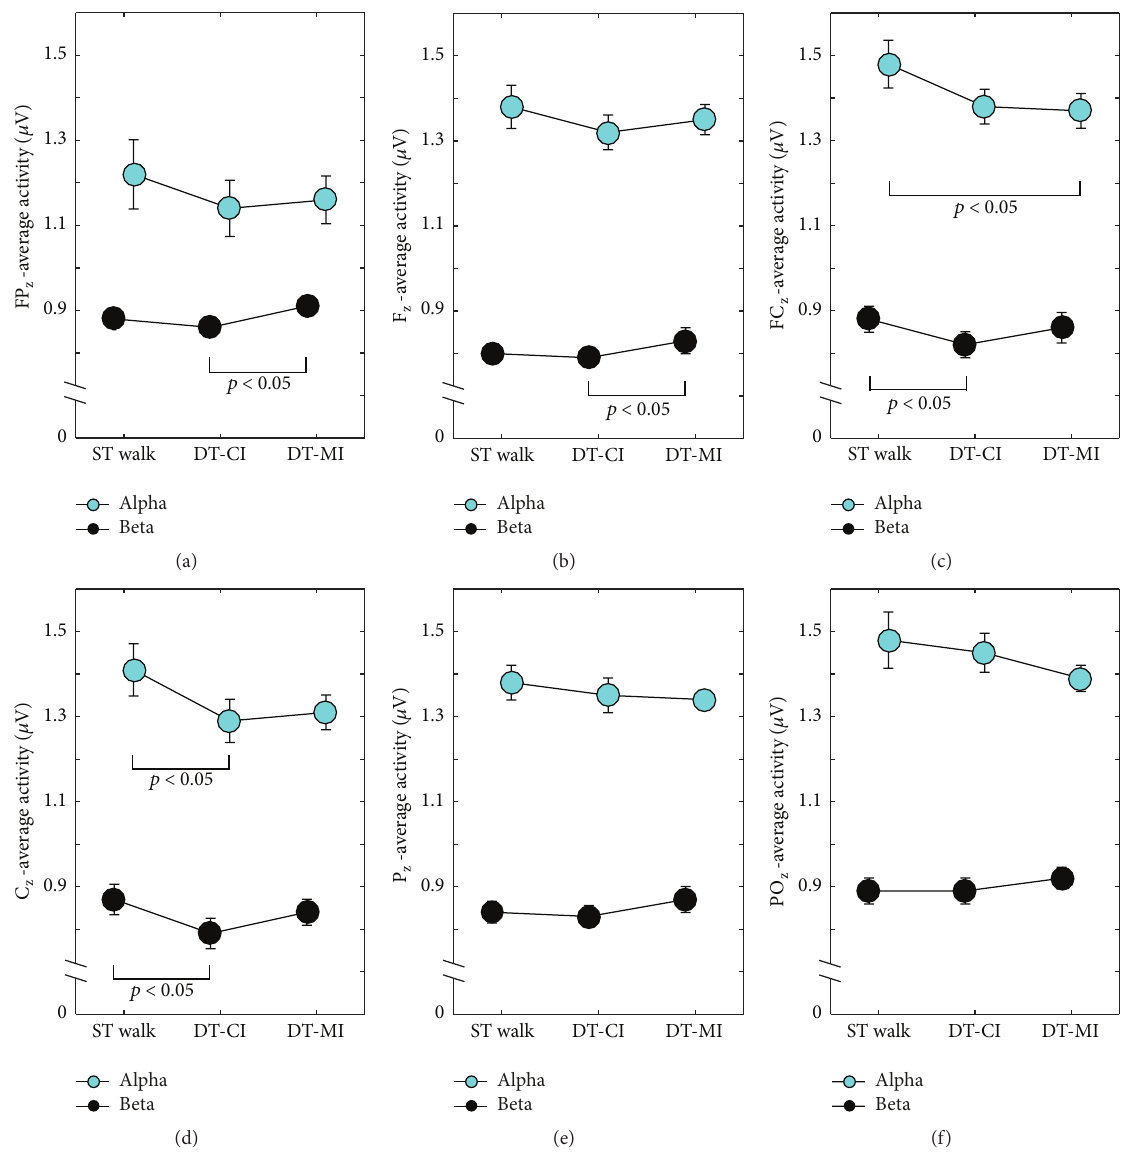
Figure 2: Subjects’ mean average voltage across the cranial midline, separated by condition (ST walk: single-task walking, DT-CI: walking + cognitive interference, DT-MI: walking + motor interference). Values represent average voltage for (a) FP z , (b) F z , (c) FC z , (d) C z , (e) P z , and (f) PO z . Cyan circles represent mean alpha frequency; black circles show mean beta frequency; error bars represent the respective 95% confidence